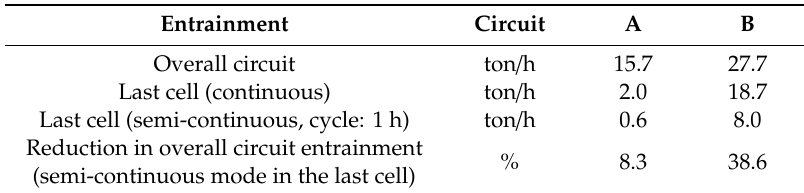
Table 3. Entrainment in circuits A and